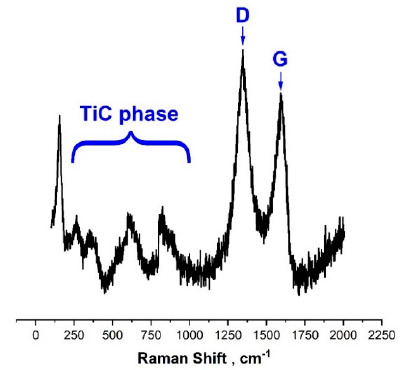
Figure 7. Raman spectra on the surface of Ti-6Al-4V simple after carburizing.